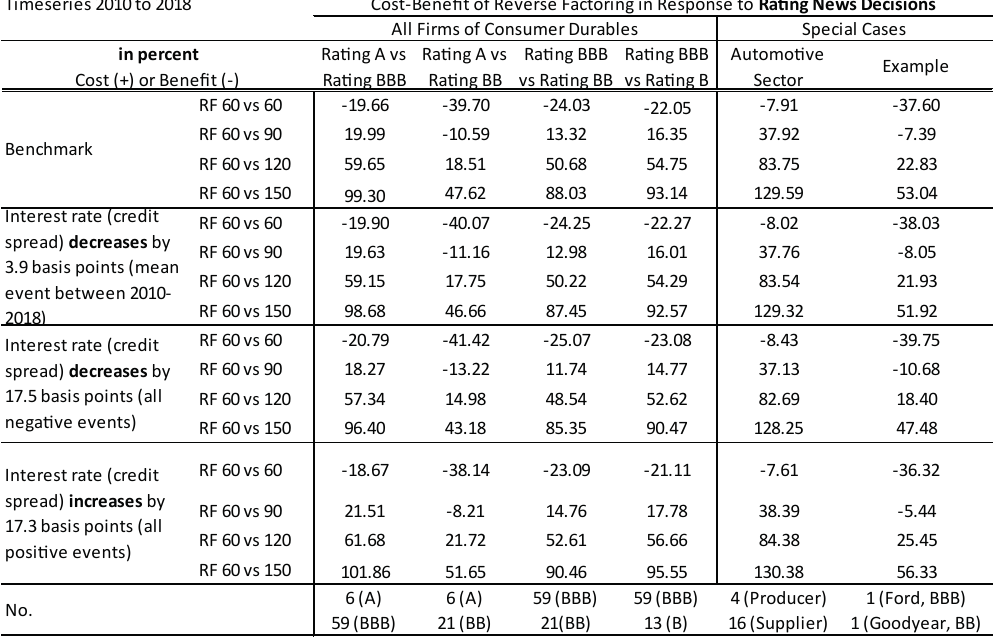
Table A2. Simulation results with rating events. Source: Authors, FactSet data